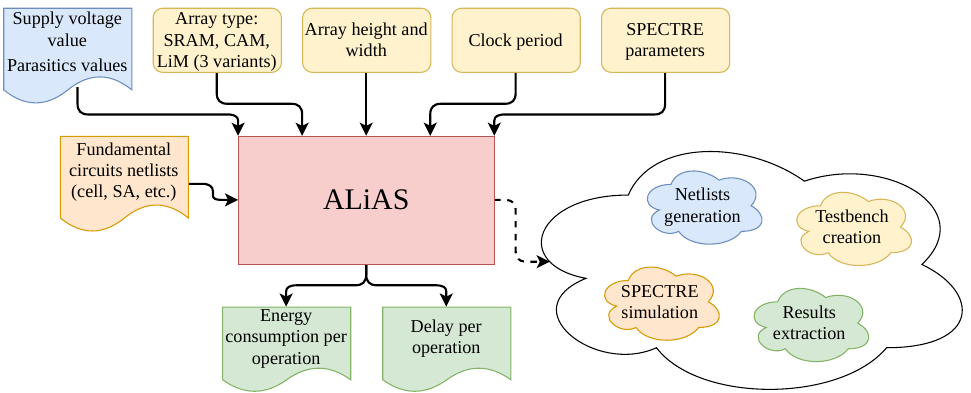
Figure 18. The scripting approach adopted, called ALiAS (Analog Logic-in-Memory Arrays Sim- ulation). Starting from the array characteristics (type and dimensions), the simulation conditions (circuit parameters, clock period, SPECTRE configuration) and the layout extracted netlists of the basic circuits (memory cells, rows and columns), a simulation is performed in SPECTRE and the array performance is